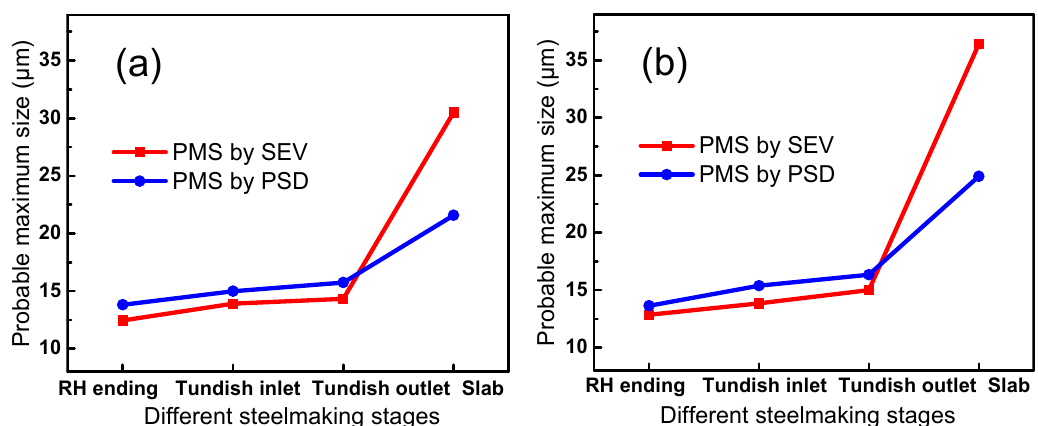
Figure 11. PMS determined by SEV and PSD at the different steelmaking stages for ( a ) Steel A and ( b ) Steel B.